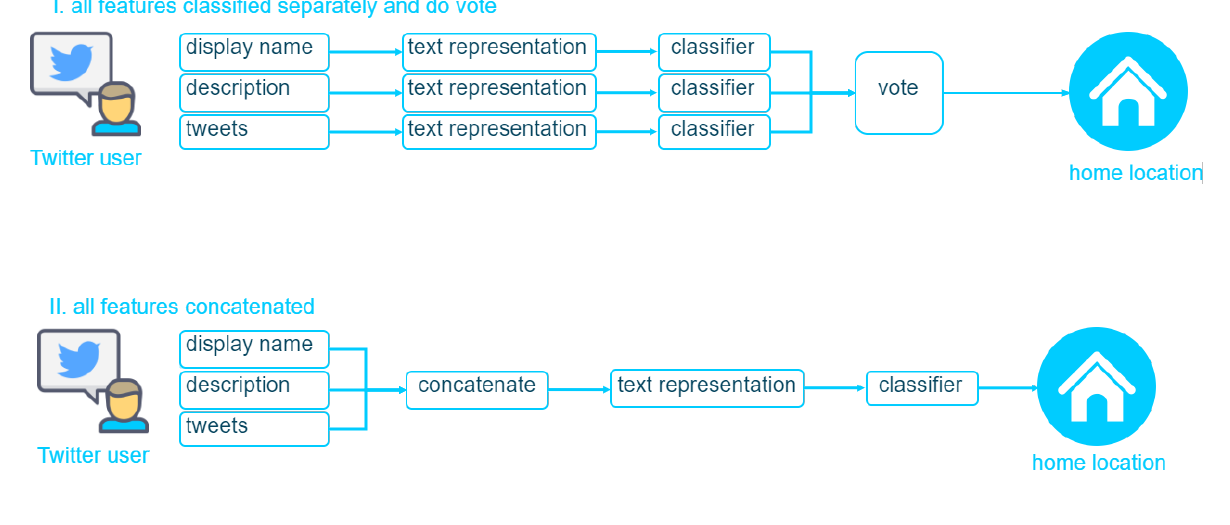
Figure 2. Overview of the model